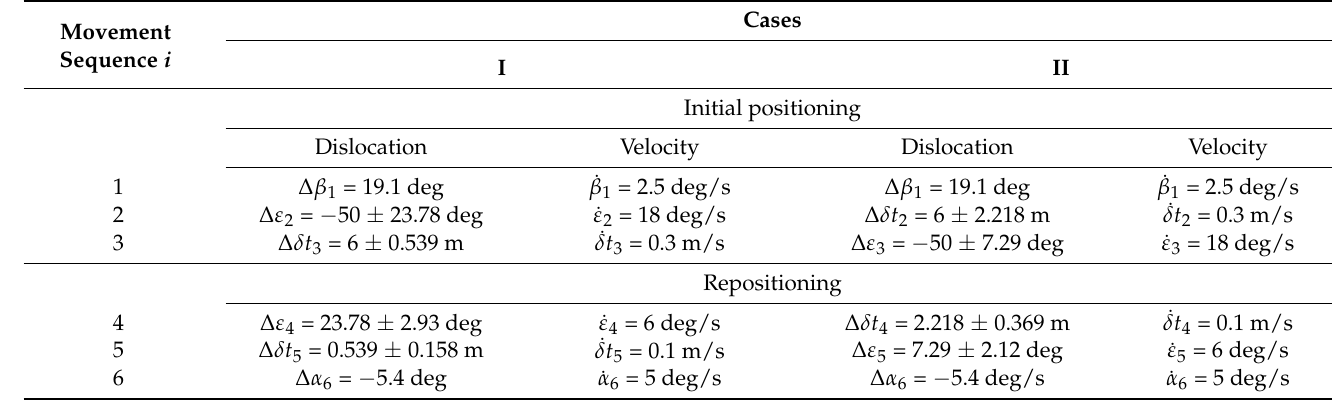
Table 4. Parameters of the working movements of the crane for two cases of the cargo handling task being